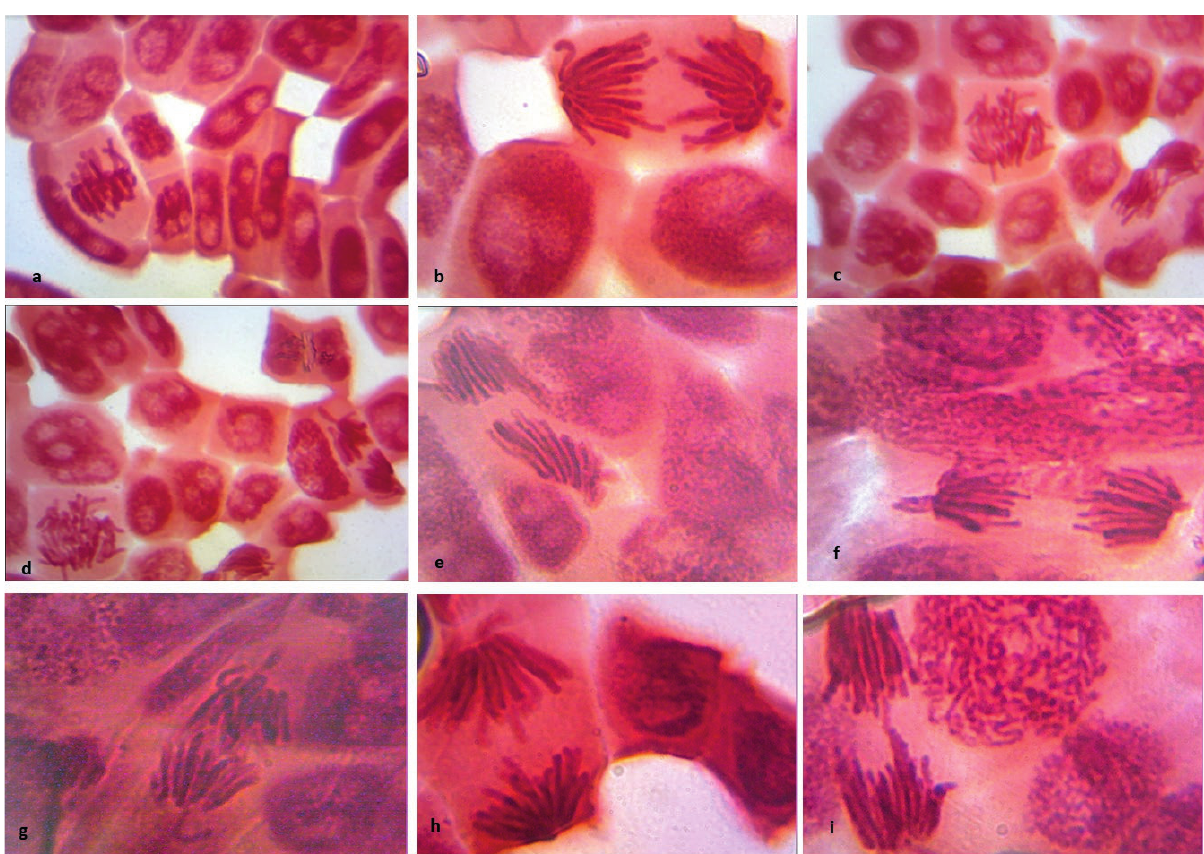
Figure 2. Allium sativum cells exposed to the ethanolic extract of Sambucus canadensis a) sticky chromosome b) bridges c) sticky and lag- ging chromosome with bridges d) lagging and sticky chromosome e) abnormal anaphase f) lagging chromosome g) vagrant chromosome and lagging chromosome, h) bridge and vagrant chromosome, i)